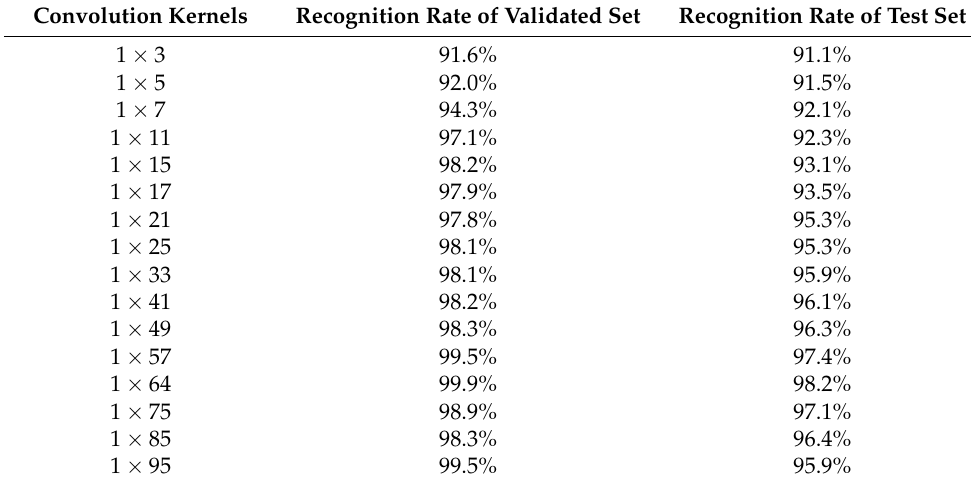
Table 2. Recognition rate for convolution kernels of different sizes. Convolution Kernels Recognition Rate of Validated Set Recognition Rate of Test Set 1 ×